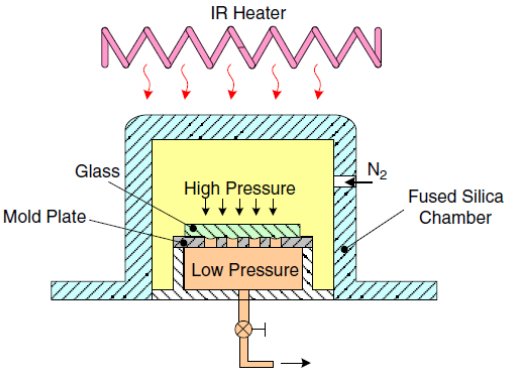
Figure 32. Schematic diagram of gas pressure-assisted glass molding machines [66].